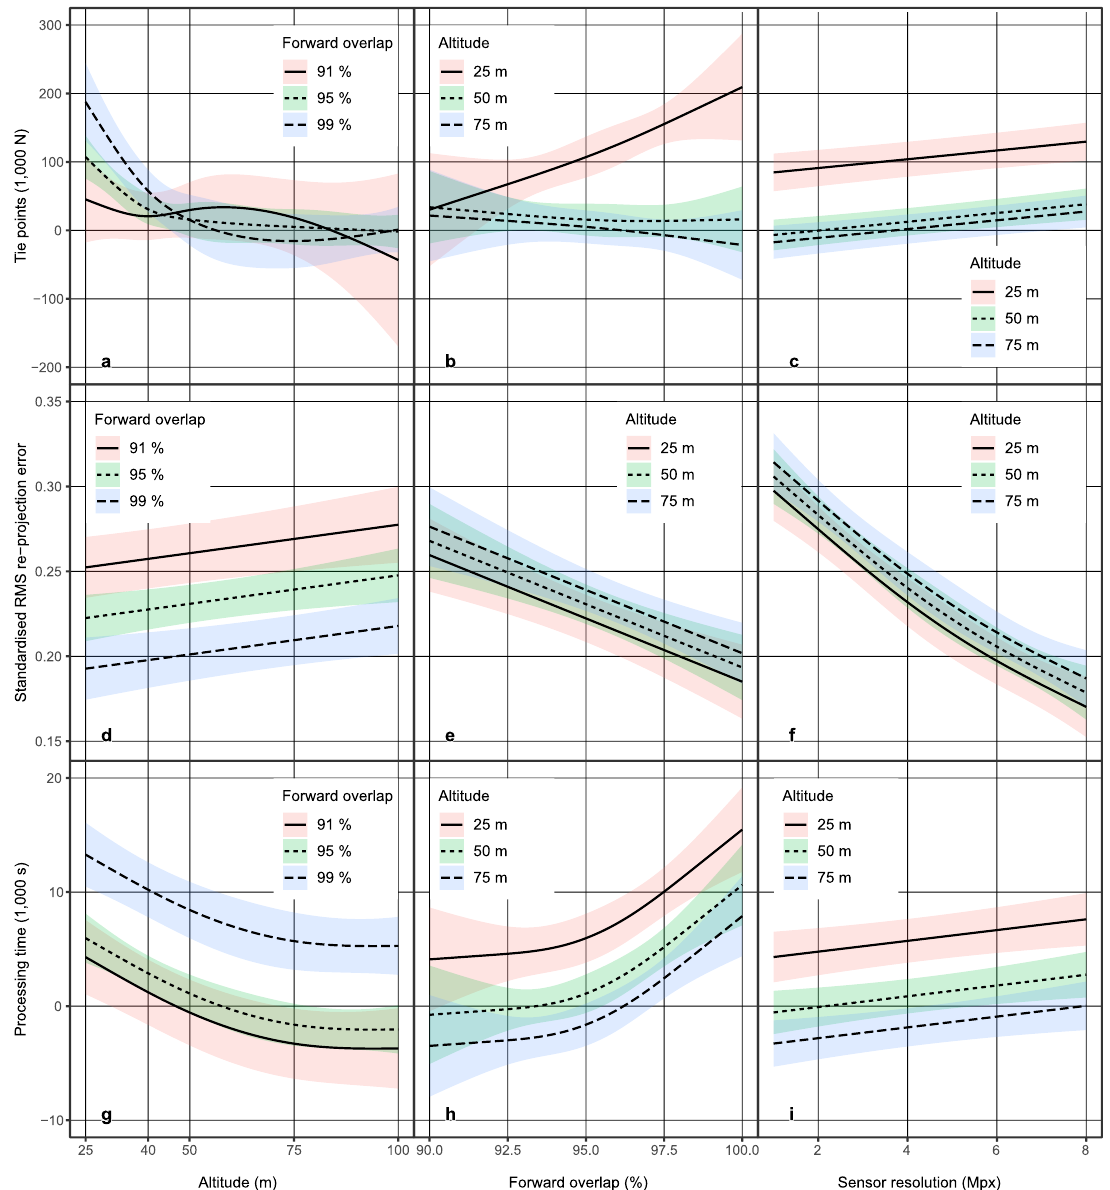
Figure 7. Trend observations for quality and efficiency parameters versus flight/sensor parameters. Displayed are the model predictions and a 95% prediction confidence interval ( p =